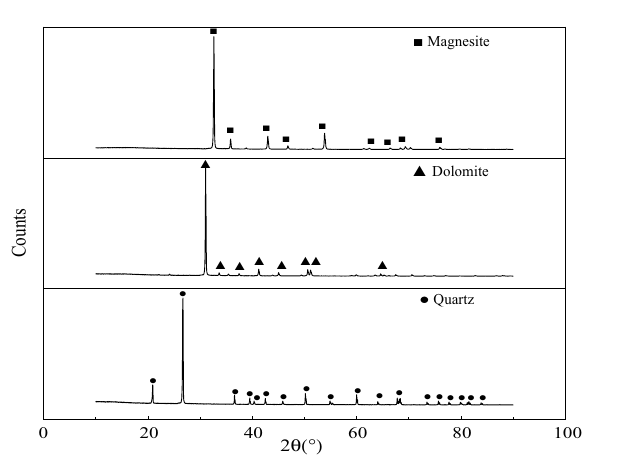
Figure 1. XRD pattern of the sample.